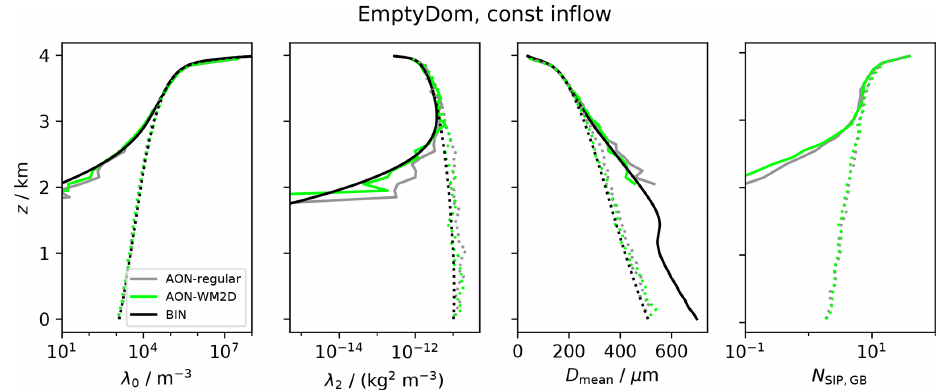
Figure 12. EmptyDom set-up: vertical profiles of moments λ 0 , λ 2 , D mean and N SIP,GB for various model versions (see legend). Depicted are the times t = 30 and 60min (solid, dotted).